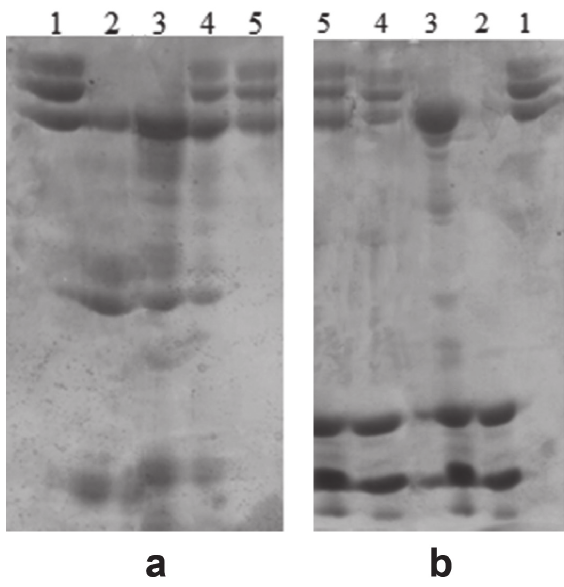
Figure 5 - Vitamins effect on fibrinogenolytic activity. ( a ) Samples: 1- Fibrinogen (60 µg); 2- Bothrops atrox venom (60 µg); 3- Fibrinogen + B. atrox venom; 4- Fibrinogen + B. atrox venom + ascorbic acid – AA (300 µg) and 5- Fibrinogen + B. atrox venom + vitamin complex – VC (300µg). ( b ) Samples: 1- Fibrinogen (60 µg); 2- Crotalus durissus terrificus venom (80 µg); 3- Fibrinogen + C. d. terrificus venom; 4-